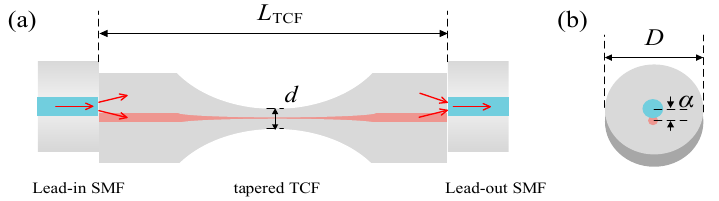
Figure 1. Schematic diagram of t -TCF structure. ( a ) Crosssectional view ( b ) side-view. According to the principle of dual-beam interference, the intensity of in-line MZI can be expressed as [35],